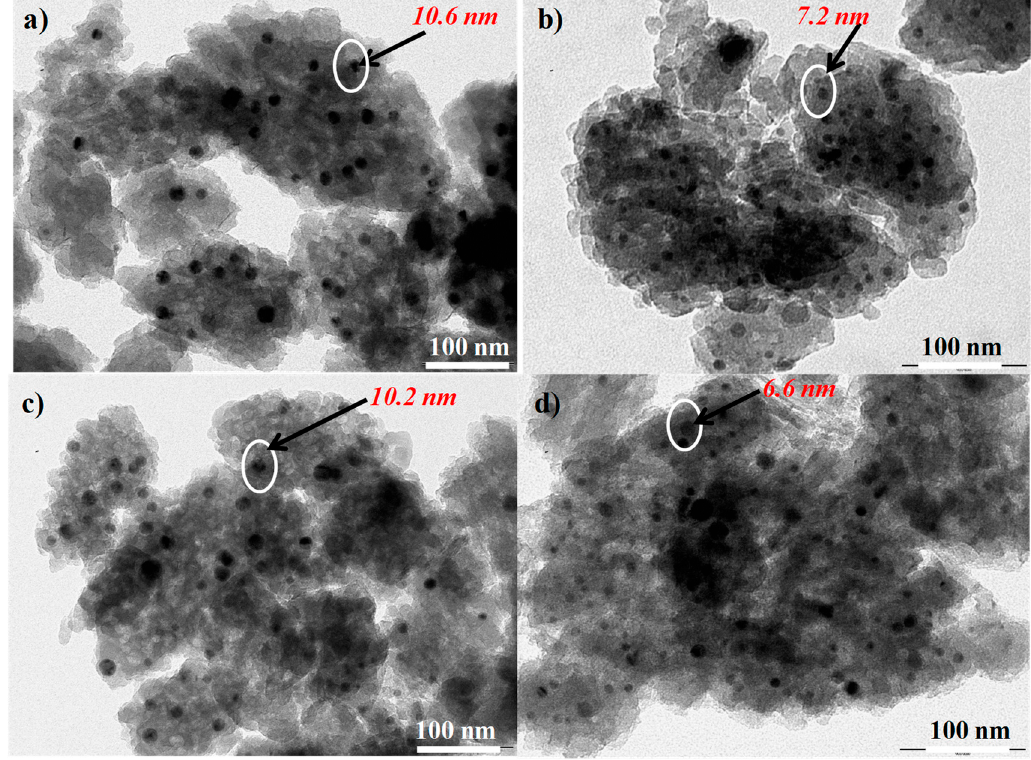
Figure 5. TEM EDS images of Red-C-Co 5.0 SiBEA reduced at 800 °C in 5% H 2 -95% Ar flow ( a ), 100% H 2 flow ( b ), 900 °C in 5% H 2 -95% Ar flow ( c ), 100% H 2 flow ( d ) showing that the size of cobalt nanoparticles does not change after reduction in higher temperature.